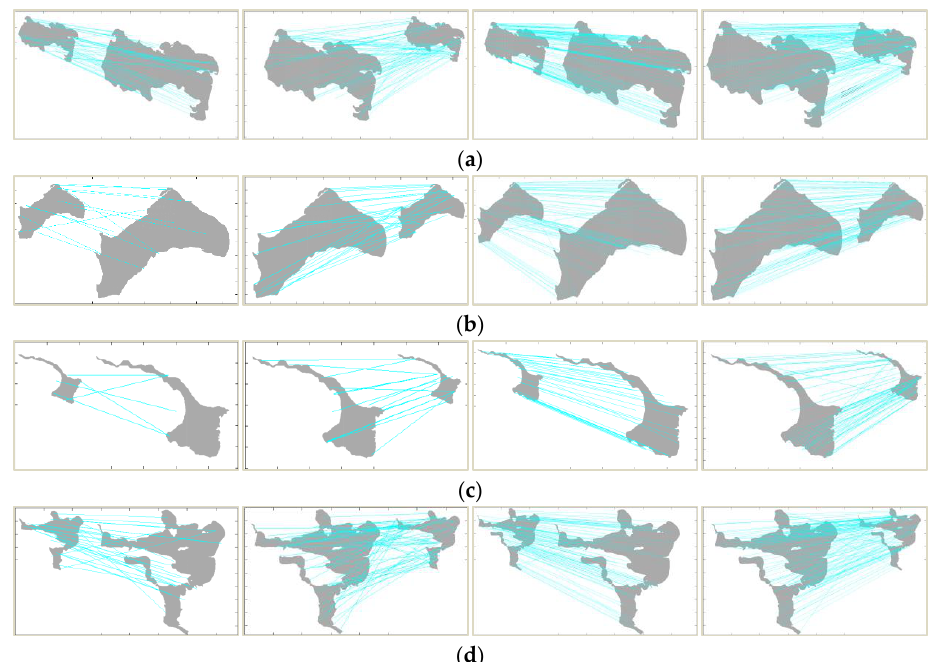
Figure 15. Matching results. ( a ) Level 10-11: 𝐿𝐶 = 0.46 , level 11-12: 𝐿𝐶 = 0.65 ; ( b ) Level 10-11: 𝐿𝐶 = 0.35 , level 11-12: 𝐿𝐶 = 0.65 ; ( c ) Level 10-11: 𝐿𝐶 = 0.26 , level 11-12: 𝐿𝐶 = 0.70 ; ( d ) Level 10-11: 𝐿𝐶 = 0.43 , level 11-12: 𝐿𝐶 = 0.61 . Table 2. Calculation results of the indices.